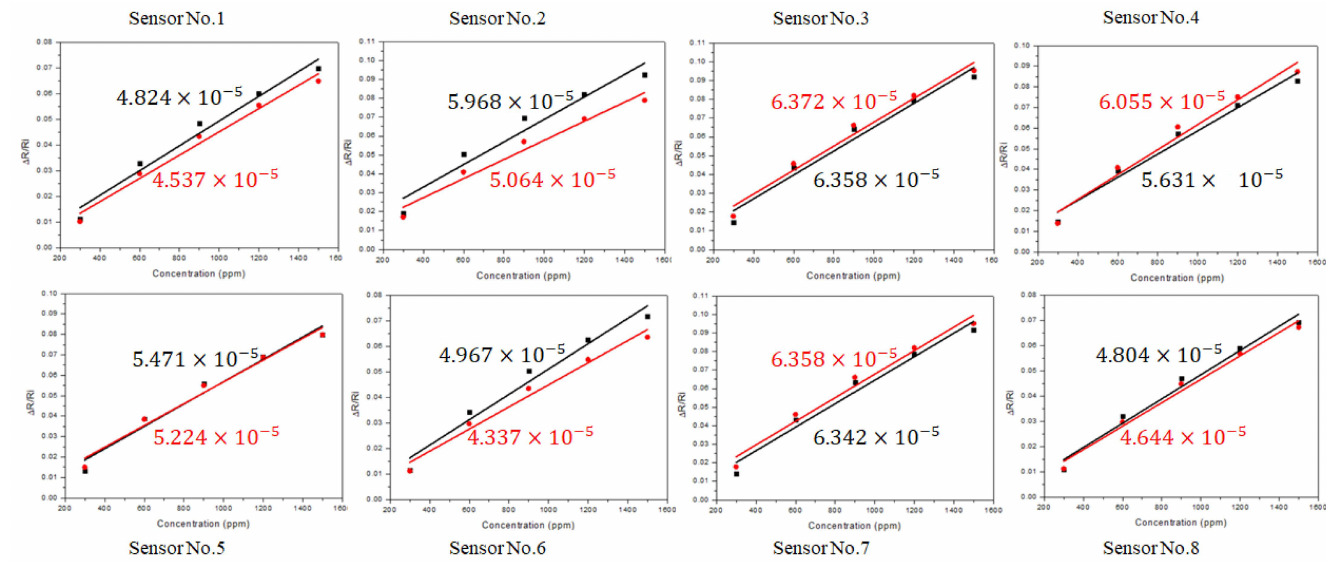
Figure 5. Plots of the responses vs. hexane vapor concentration for the sensor array measured by HCD (red data points) and KMM (black data points). The response sensitivities (ppm − 1 ) are indicated by the slopes in the